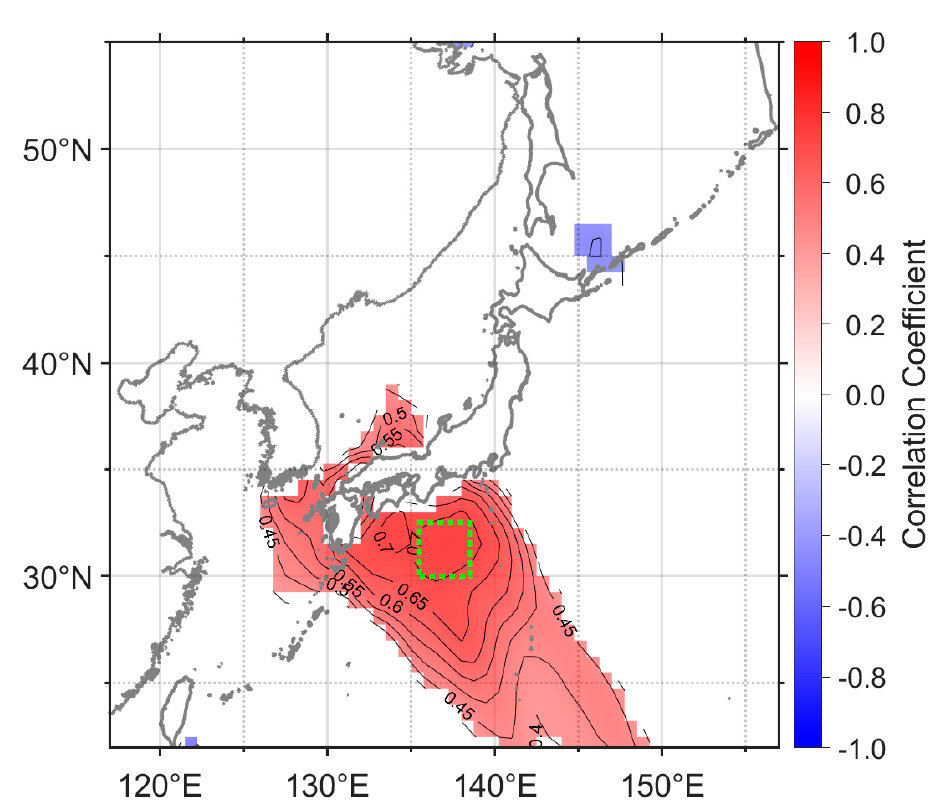
Figure 7. Correlation map of the NEAMS August sea-level with the northwestward (main wind direction in August in the NEAMS) surface wind stress from 1993 to 2018. The contour interval is 0.05 and confidence levels less than 95% were eliminated. A positive correlation means that high NEAMS sea-level occurs with strong northwestward wind stress and a negative correlation means that high NEAMS sea-level occurs with weak northwestward wind stress. Here, the wind index area (WA) showing the maximum positive correlation coefficients is marked with a green dotted box.